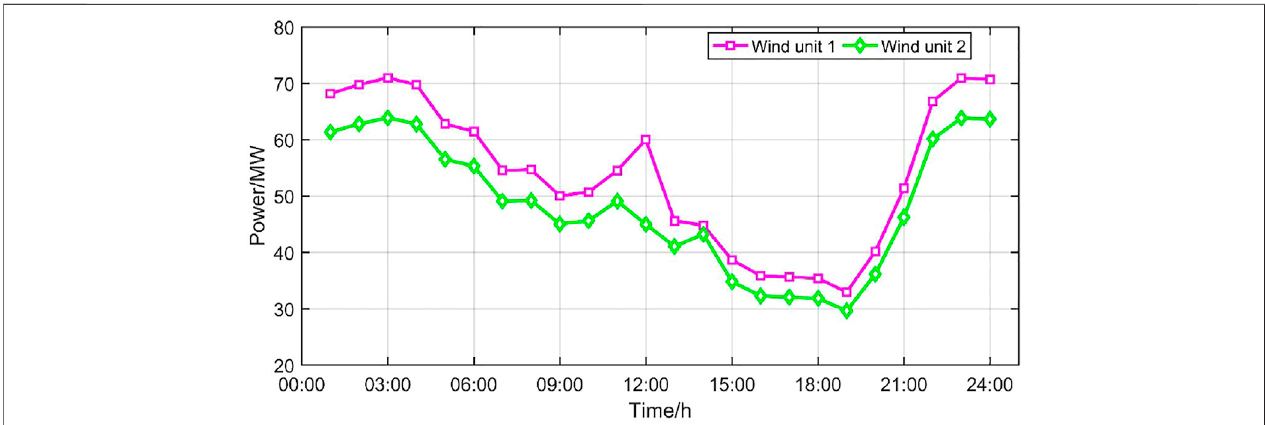
FIGURE 6 | Bidding energy of wind power producers.